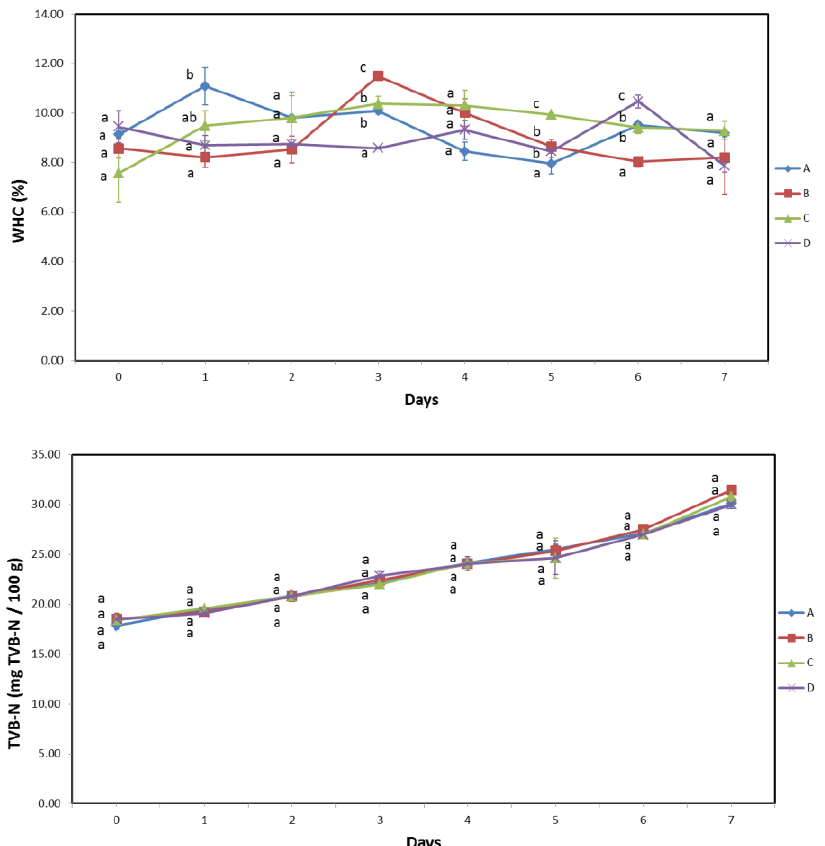
Figure 3. pH value of muscle tissue, water holding capacity, and TVB-N content of samples A and B handled by the traditional method, and samples C and D handled by modified handling method during 7 days of storage at 0 °C. Capital letters A, B, C and D (legend) indicate different sample batches. Lowercase letters (a, b, c, d) on the same day indicate significant differences among different sample batches ( p ≤ 0.05).